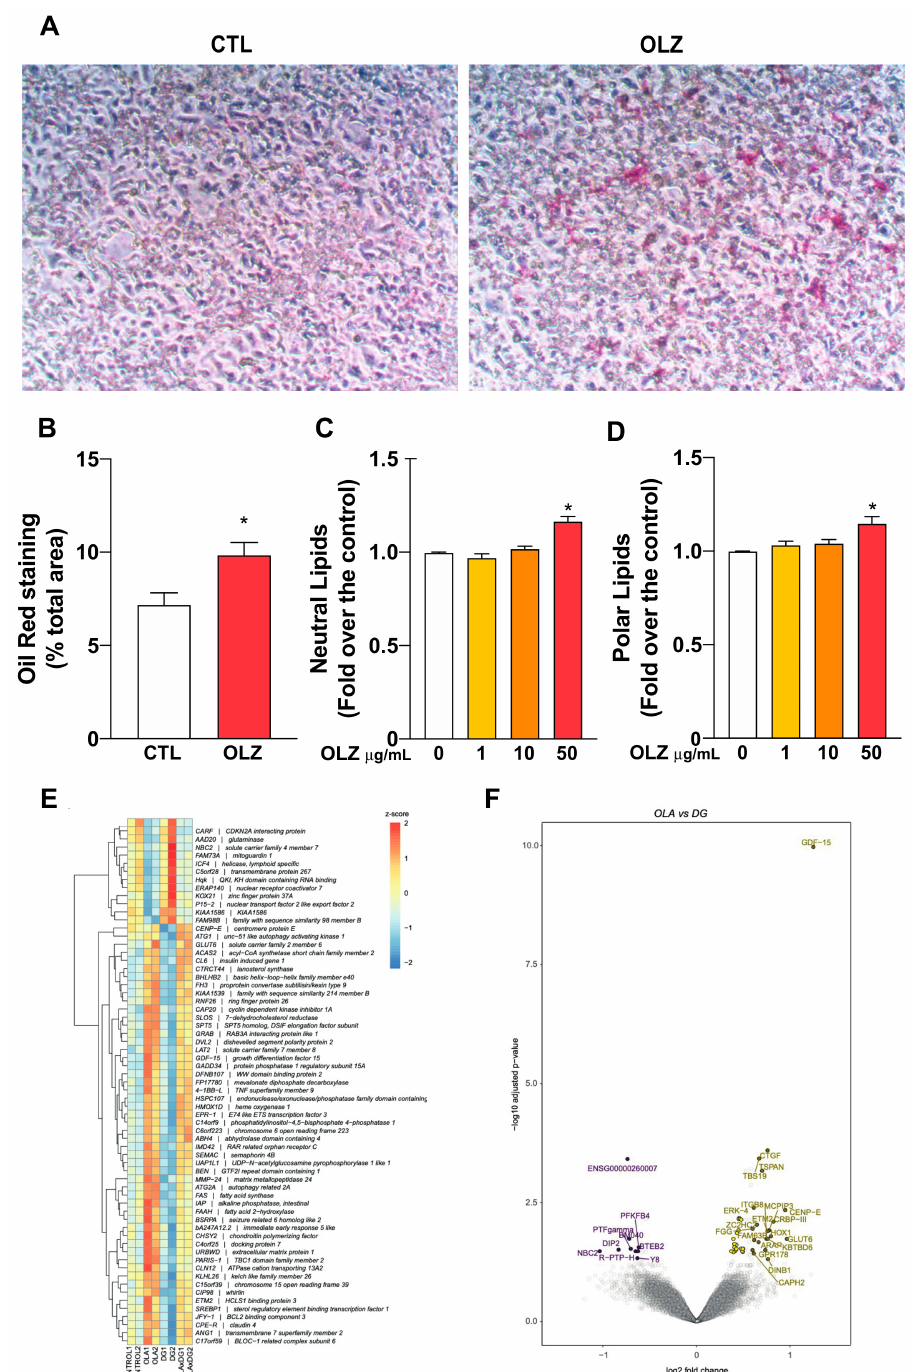
Figure 2. Effect of olanzapine on HepG2 cells’ lipid content. ( A ) Representative images of control and OLZ-treated HepG2 cell cultures visualized by optical microscopy 20X. ( B ) OLZ-treated cells showed a significant increase in total lipid content. ( C ) Neutral lipids quantification by Nile red and ( D ) polar lipids quantification by Nile Red * p < 0.05 vs. CTL (0 µ g/mL). ( E ) The heatmap shows the normalized gene expression levels for 65 differentially expressed genes found when comparing OLZ and DG treatments. Expression for the two replicates of control (Control 1 and Control 2), OLZ-treated (OLZ1 and OLZ2), DG-treated (DG1 and DG2), and OLZ + DG-treated (OLZxDG1, OLZxDG2) cells are shown. Gene expression values were normalized by row using z-scores ( F ). The Volcano plot shows genes differentially regulated when comparing OLZ and DG treatments. Differentially expressed genes (FDR < 0.05) are shown as purple (higher expressed by DG) and yellow (higher expressed by OLZ) circles. Names are indicated for those genes showing at least a 1.5-fold expression difference between treatments. Circles in grey show genes with no differential